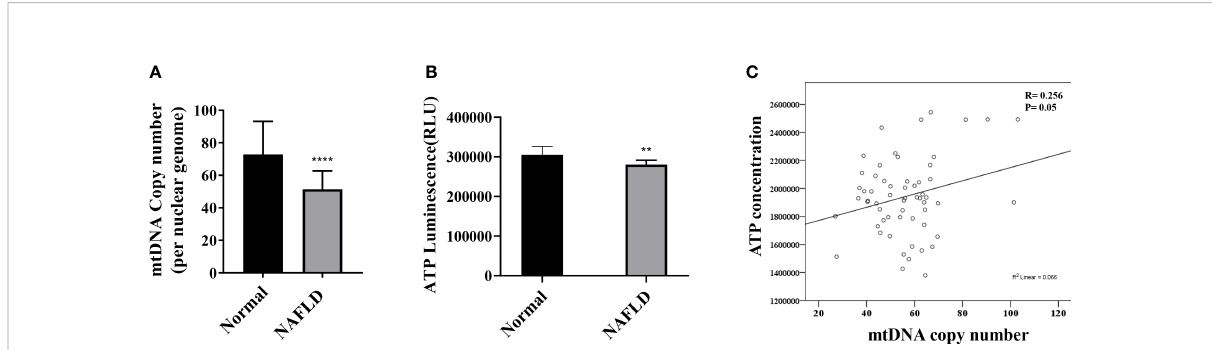
FIGURE 3 Mitochondrial copy number and mitochondrial ATP inhibition substrate test in NAFLD. (A) Results of mitochondrial DNA (mtDNA) copy number decreased in the peripheral blood of NAFLD patients than that in the control. ****P < .0001 compared with the control. (B) ATP decreased in the serum isolated from the peripheral blood of NAFLD patients than that in the control (**P=0.001 – 0.01). (C) Positive correlation between the mtDNA copy number and ATP (R = 0.256, P =